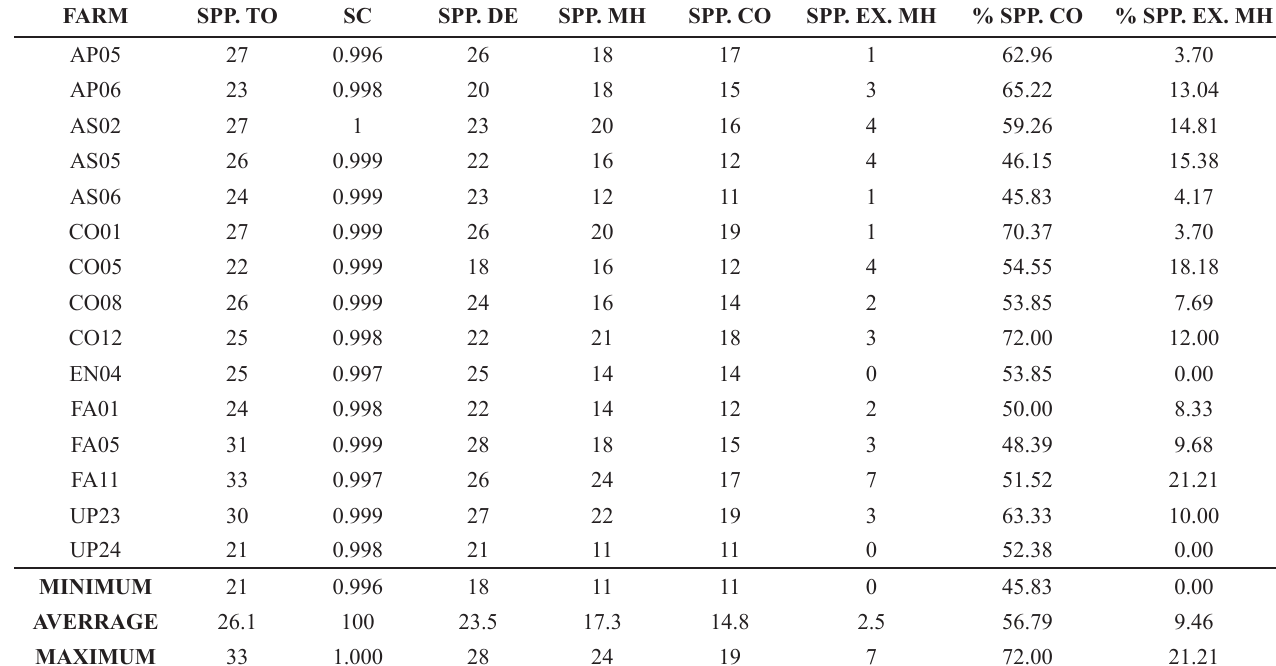
Table 3 . Species of ants per farm: Total number of species (SPP.TO); Sample coverage (SC); species in ‘dehesas’ (SPP.DE); species